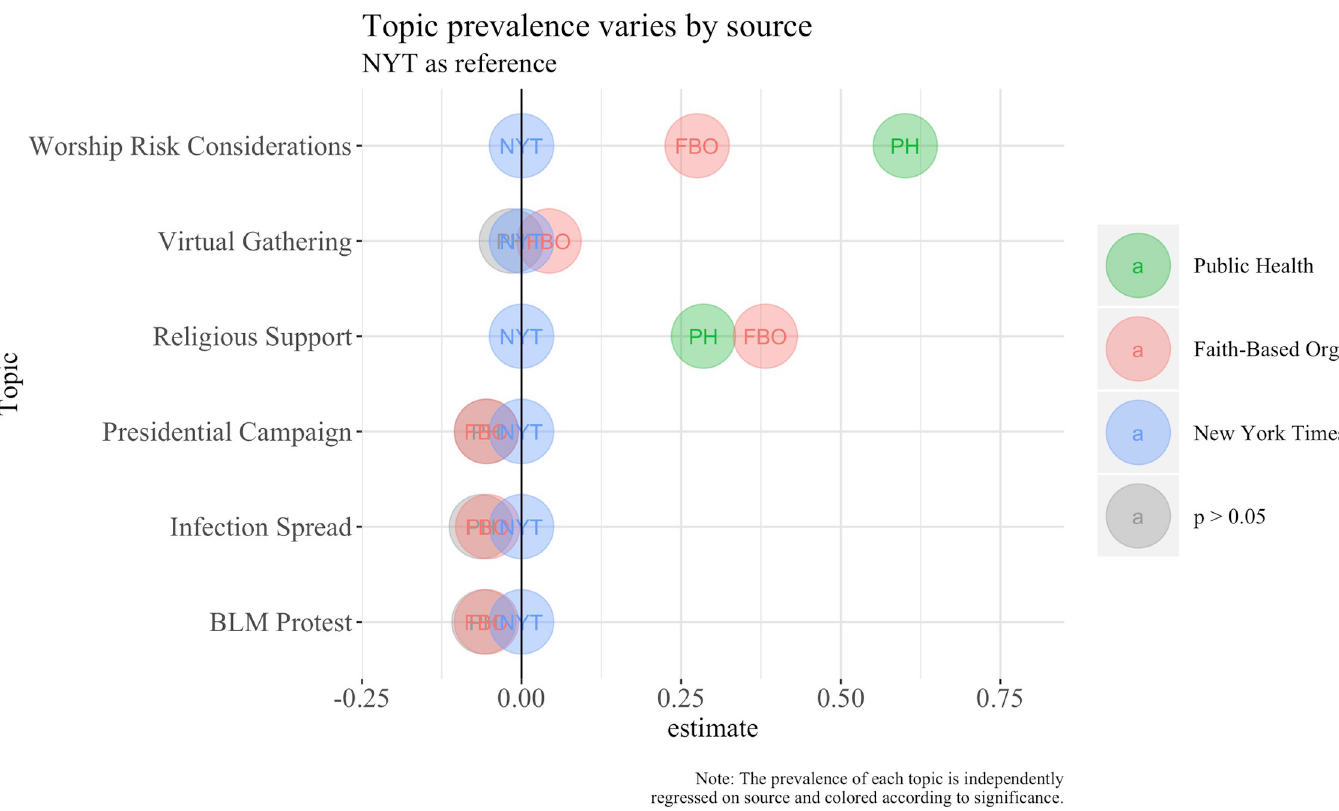
Fig 2. Topic prevalence differences by source, with New York Times as reference